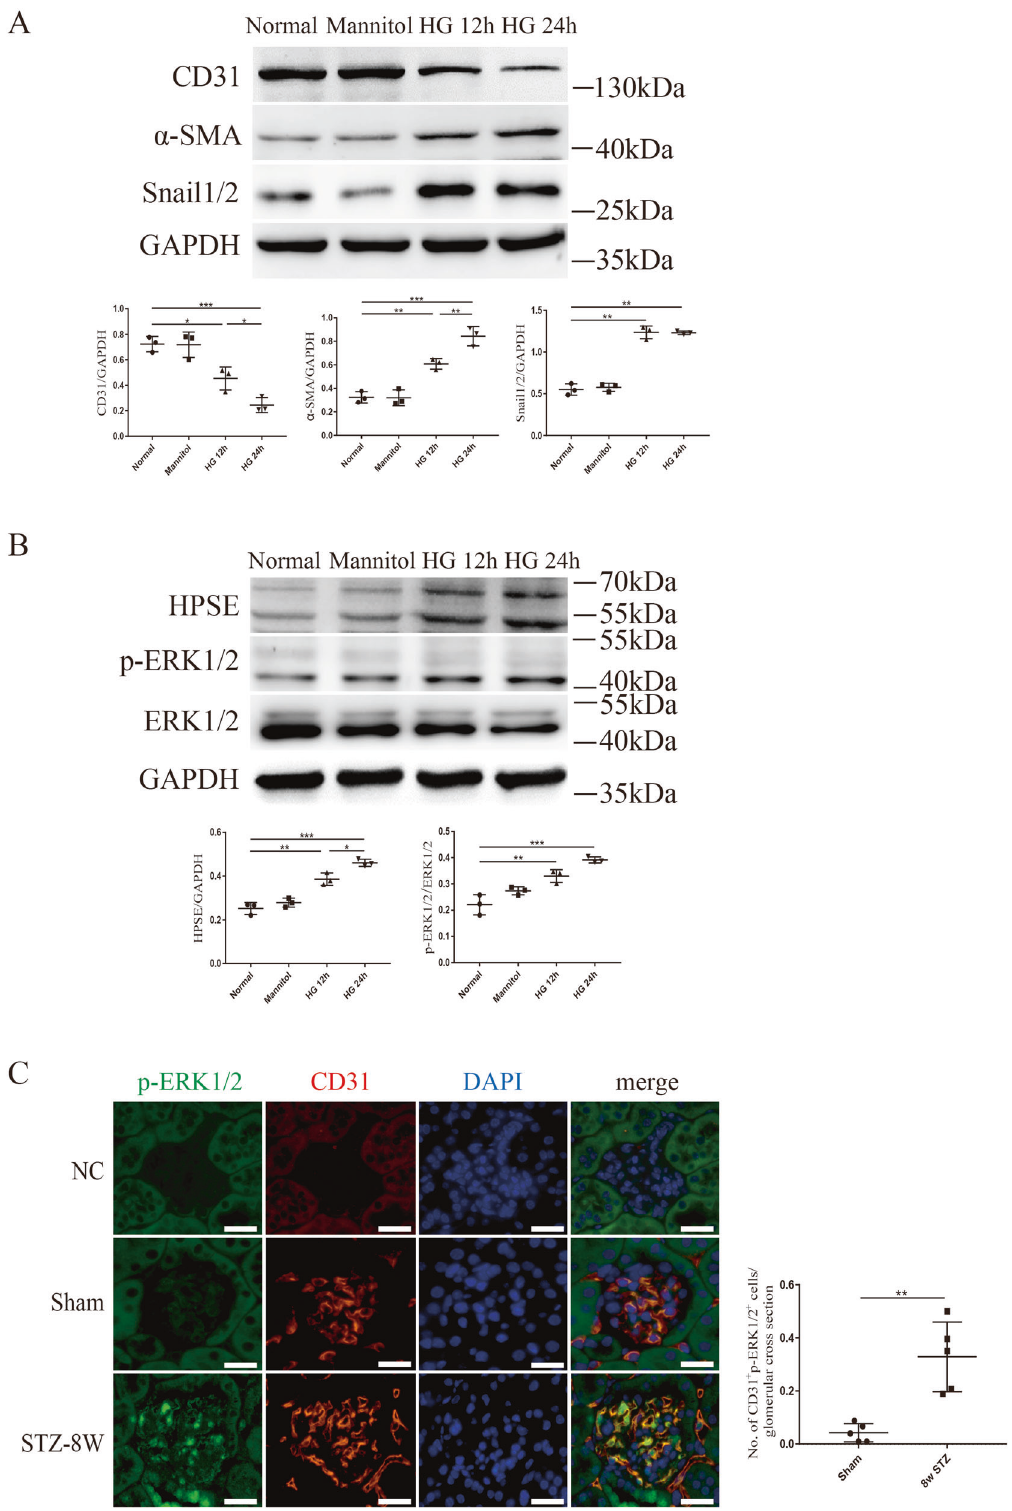
Fig. 4 High glucose promoted EndMT in cultured GEnCs through upregulating HPSE and p-ERK1/2. A High glucose signi fi cantly decreased the protein level of CD31 while increased the expressions of mesenchymal markers including α -SMA and Snail1/2. B The protein levels of HPSE and p-ERK1/2 were signi fi cantly upregulated by high glucose treatment. C The count of double positive IF staining for p-ERK1/2 and CD31 was dramatically increased in STZ-induced diabetic mice, compared with the negative double staining in sham animals. Scale bar = 10 μ m. Each vertical bar represents the mean ± SD ( n = 3) analyzed by one-way analysis of variance (ANOVA) followed by Tukey ’ s multiple comparisons test. * P < 0.05, ** P < 0.01, and *** P < 0.001.